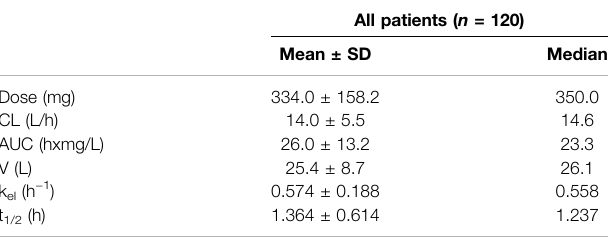
TABLE 3 | Values of the pharmacokinetic parameter obtained in the present 120 children by the fi nal POP/PK model. There were not statistically signi fi cant differences between males and females.